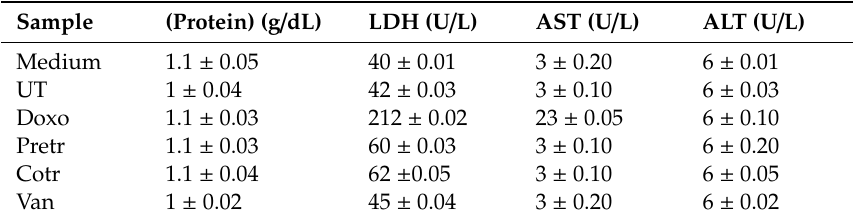
Table 1. E ff ect of vanillin on doxo-induced cellular damage. The release of AST, ALT, LDH intracellular enzymatic activities was evaluated in cultured media of H9c2 cells exposed to 20- µ M doxo for 24 h, pretreated (Pretr) and cotreated (Cotr) with 100- µ M vanillin. Values are means ± S.D. of triplicate samples of a typical experiment. Medium: cultured medium without cells; UT: untreated cells; doxo: cells exposed to doxo; Van: cells exposed to vanillin.